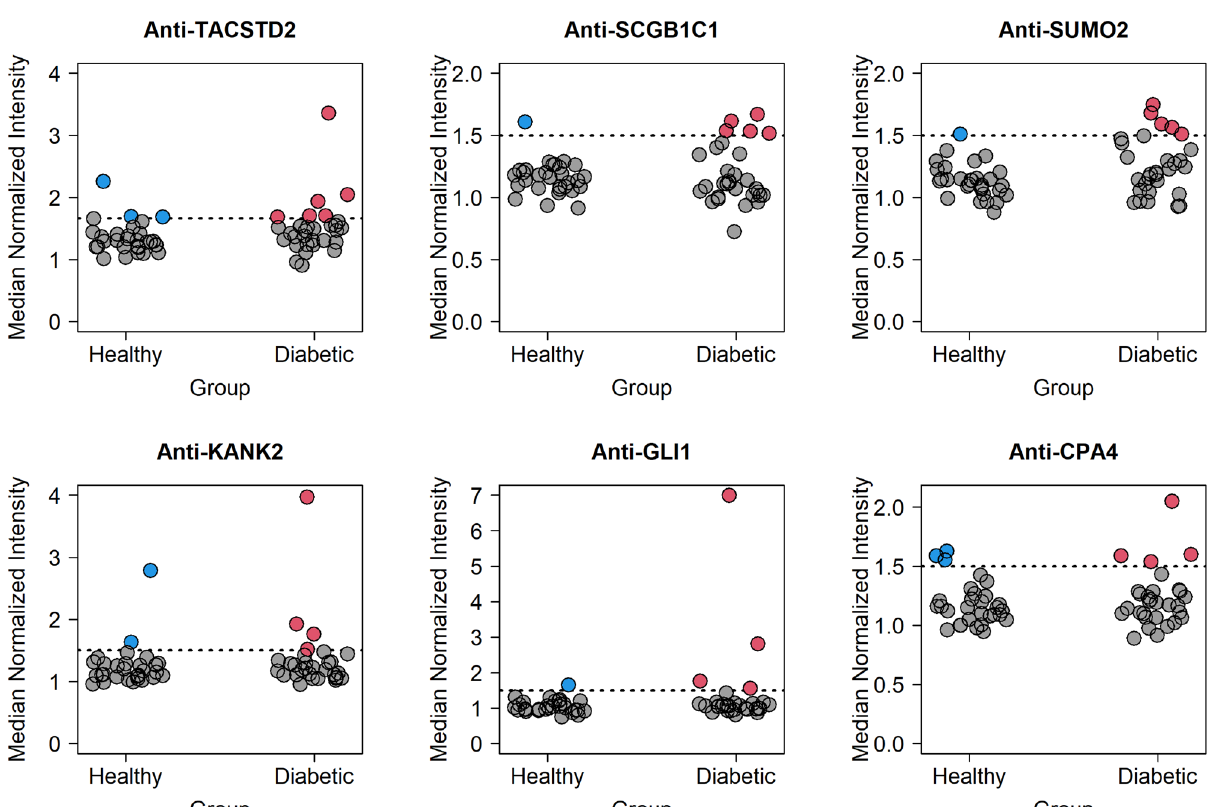
Figure 2. Reactivity of antibodies with sensitivities > 10% in diabetic and healthy dogs. Each dot represents an individual dog and the reactivity to the respective antibody. The horizontal dashed line represents the maximum between either the 90% percentile of the control samples or 1.5 and sensitivity is the proportion of red dots in the diabetic